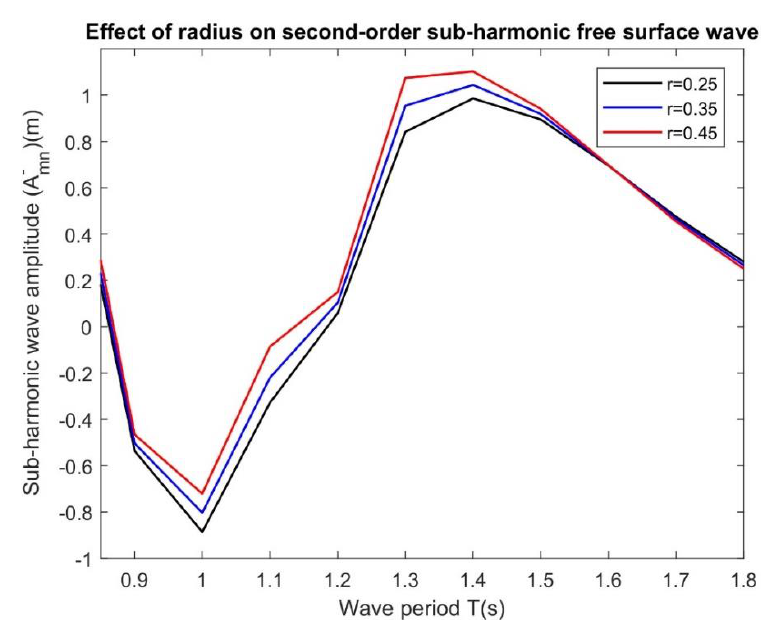
Figure 18. E ff ects of radius of the cylinder r on second-order sub-harmonic wave amplitude A − mn of Figure 18. Effects of radius of the cylinder r on second-order sub-harmonic wave amplitude mn A Equation (29) in location B for h = 4.0 m, k m = 0.84 and z α = 0.5. Equation (29) in location B for h = 4.0 m, k m = 0.84 and z α = 0.5.